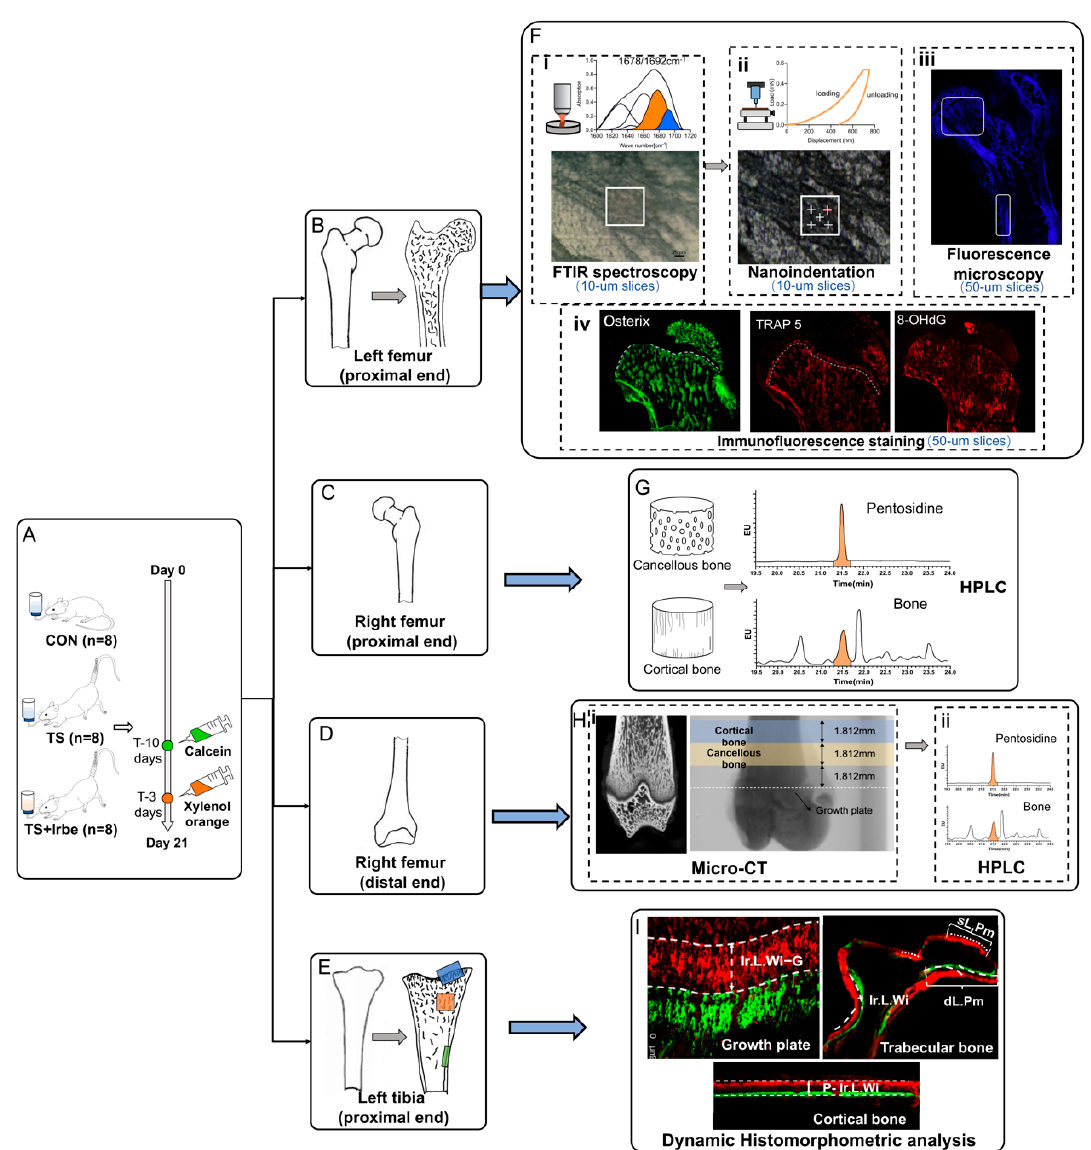
Figure6. Schema illustrating key aspects of the experimental procedure. ( A ) Calcein (5 mg/kg) and Xylenol orange (90 mg/kg) were administered 10 and 3 days prior to the end of the study to label actively forming bone surfaces. After sacrifice, the proximal ends of left femur in rats were decalcified, embedded, and cut into frozen slices ( B ), and NE − xLR was analyzed by FTIR ( Fi ); bone micromechanical properties were determined by nanoindentation( Fii ), the box indicates the detection locations of FTIR and nanoindentation ( 100μm × 100μm ) ; fluorescent AGEs were observed by autofluorescence microscopy ( Fiii ); the expression of Osterix, TRAP, and 8-OHdG were analyzed by immunofluorescence staining ( Fiv ). The proximal ends of right femur were divided into cancellous and cortical bone ( C ), and PEN content in bone matrices were determined by HPLC ( G ). The distal ends of right femur ( D ) were scanned and reconstructed to analyze bone microstructure by Micro-CT ( Hi ), and PEN content of corresponding sites of cancellous bone and cortical bone were also determined by HPLC ( Hii ). The proximal ends of left tibia were embedded and cut into slices for dynamic histomorphometric analysis ( E ), and the MAR/BFR at growth plate (blue diamond), trabeculae (orange diamond) and cortical endosteum (green diamond) were measured ( I ).